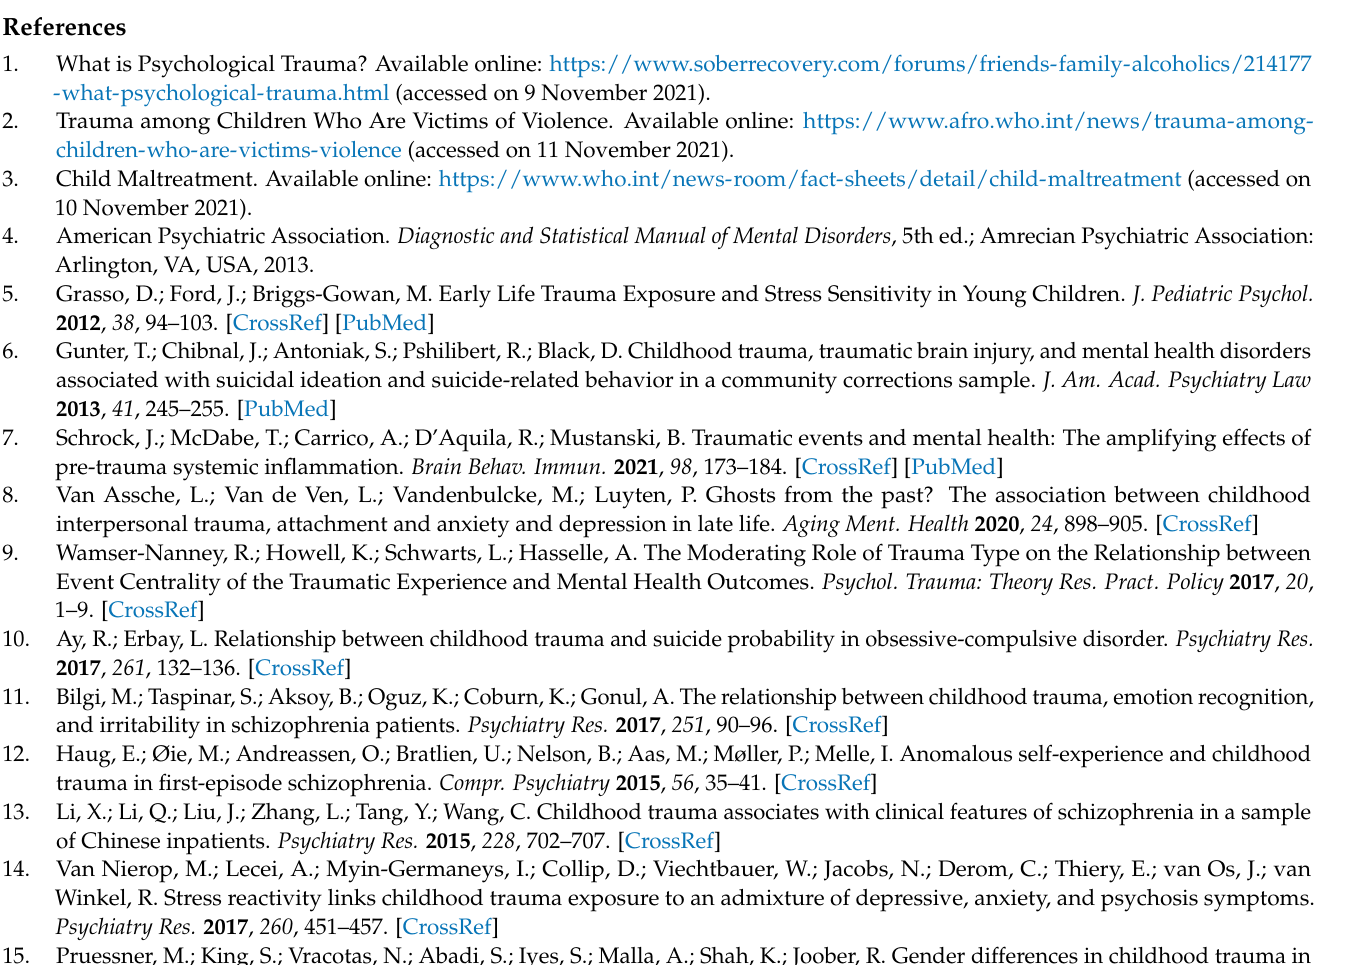
Table S2: Results for mental health symptoms; Table S3: Incidence of suicidal behavior; Table S4: Correlation values among mental health symptoms and traumatic experiences; Table S5: Correlation values among suicidal behavior and traumatic